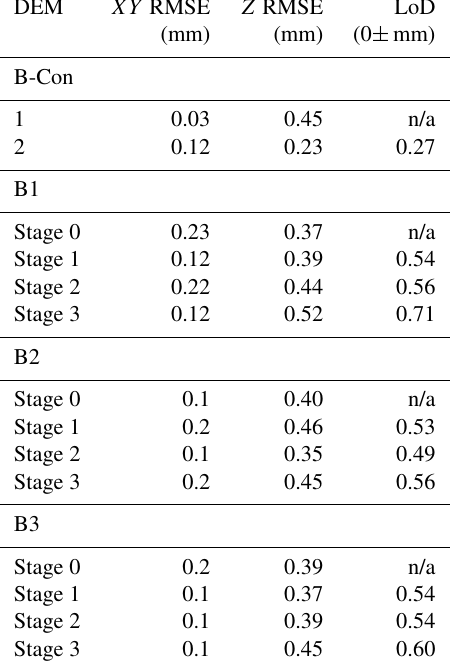
Table 1. The horizontal ( XY ) and vertical ( Z ) RMSE for the control block (B-Con) and the experimental blocks B1, B2, and B3. LoD for each DoD is also shown. n/a – not applicable.